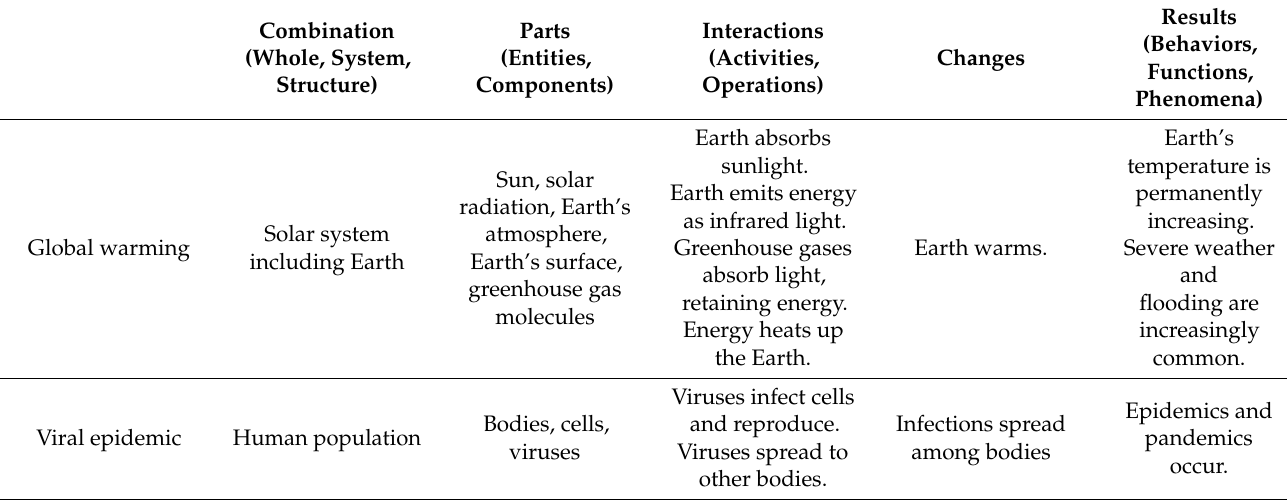
Table 1. Mechanisms relevant to global warming and viral epidemics. In the top row, the parentheses show the range of terminology used in philosophical discussions of mechanisms. The other rows describe the operation of climate [12] and viral [13]